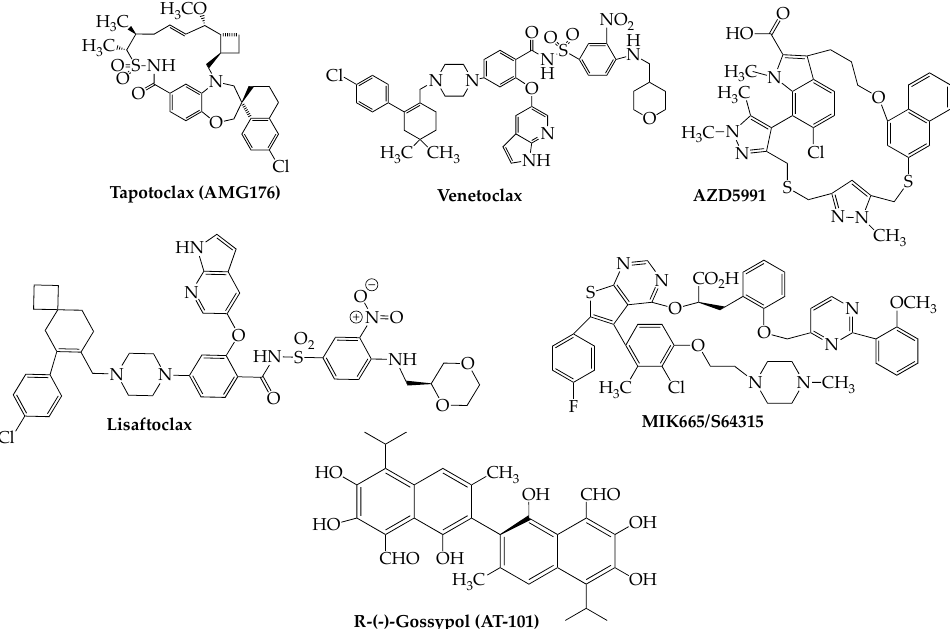
Figure 5. Chemical Structures of Apoptosis Inducers Active Against Myeloma.